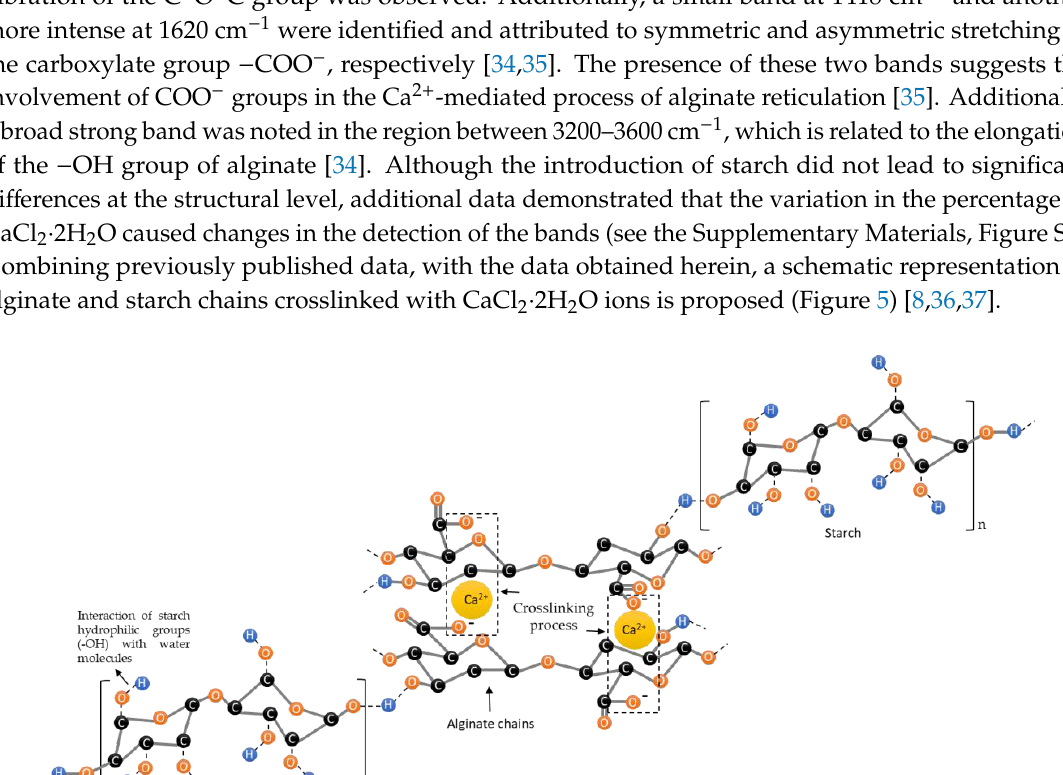
Figure 5 . Representation of alginate and starch chains crosslinked with CaCl 2 ·2H 2 O ions. Figure 5. Representation of alginate and starch chains crosslinked with CaCl 2